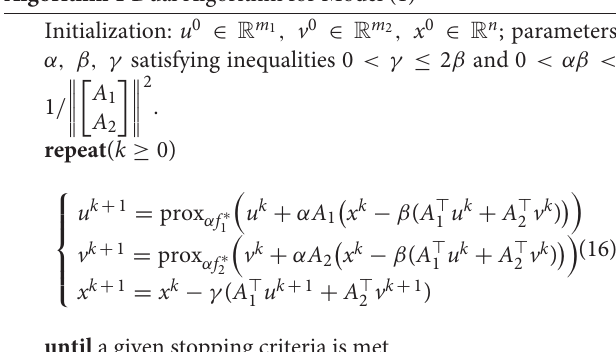
Algorithm 1 Dual Algorithm for Model (1)